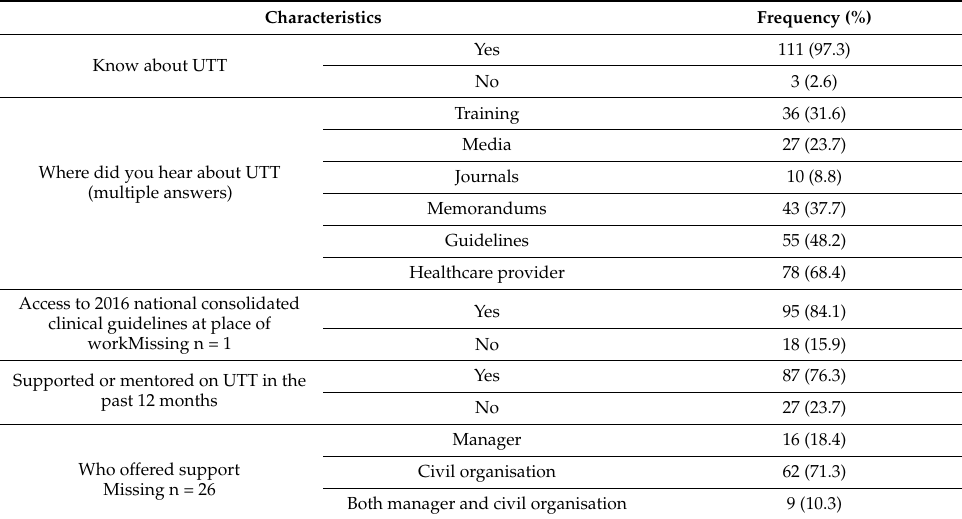
Table 2. Access to and availability of UTT